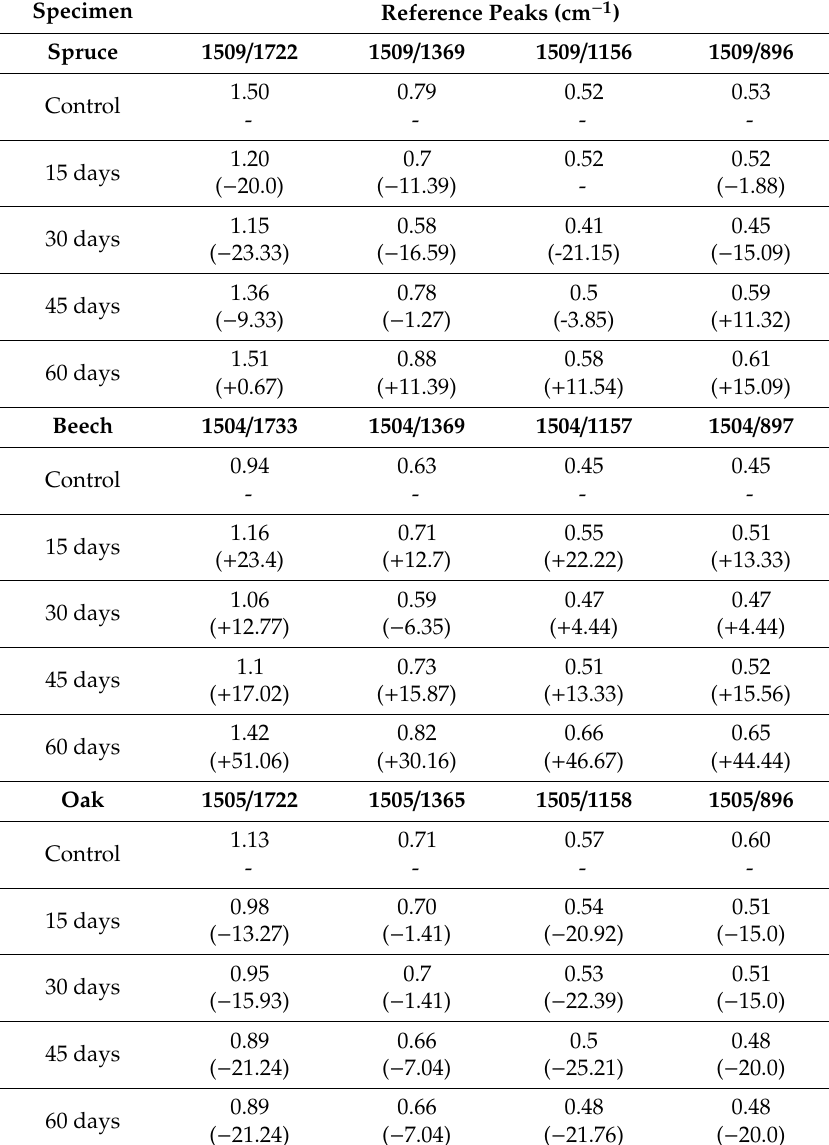
Table 3. The ratio of the intensity of lignin associated bands with carbohydrate bands for wood blocks degraded by T.